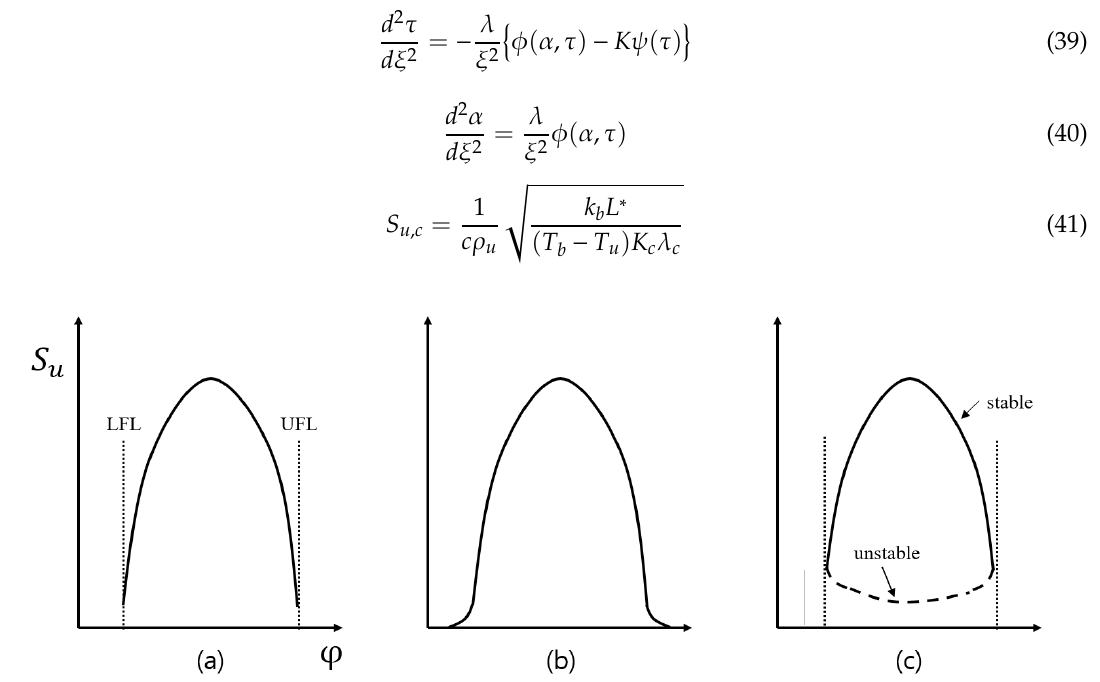
Figure 17. Burning velocity against equivalence ratio. ( a ) experimental findings, ( b ) prediction of previous studies neglecting heat loss, ( c ) prediction of Spalding’s study. Reproduced from Ref. [97], The Royal Society: 1957.